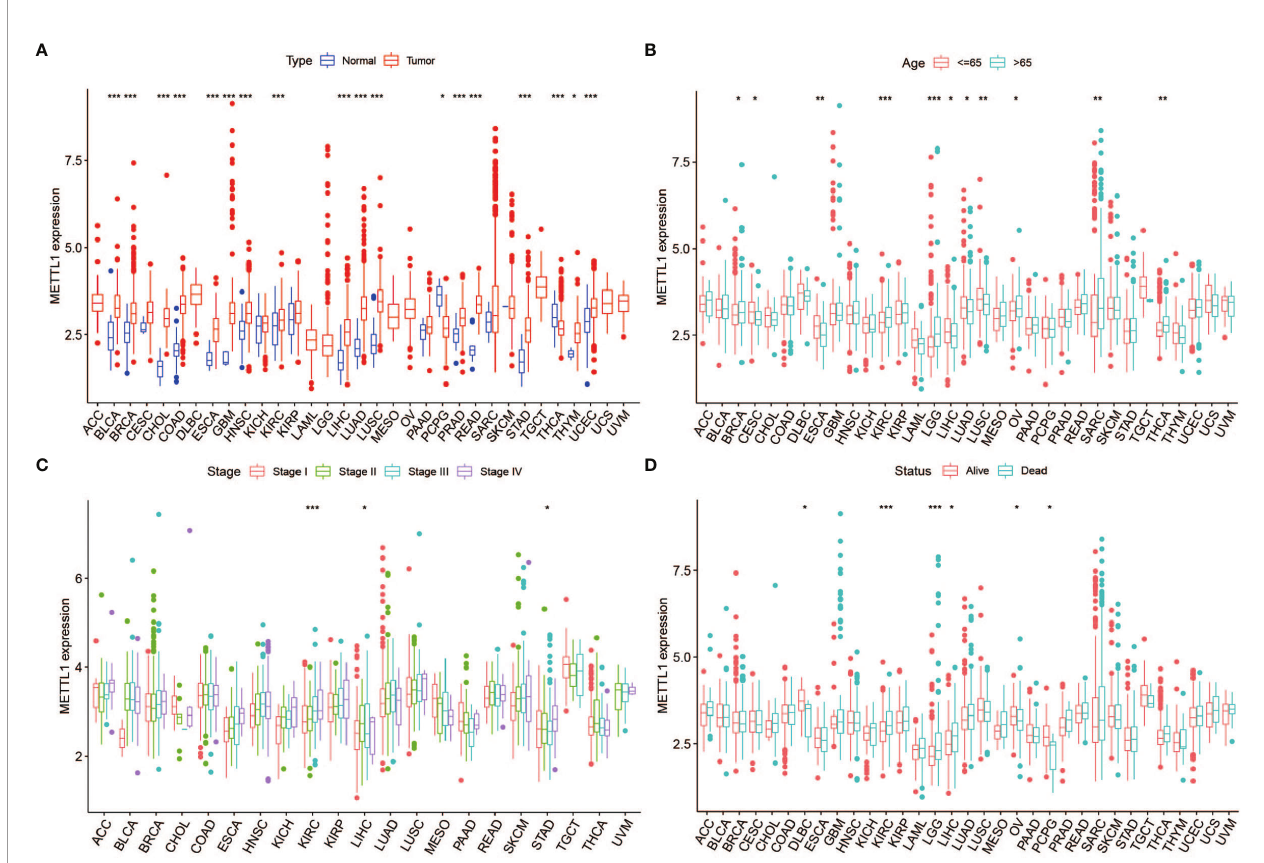
FIGURE 2 | Correlation between METTL1 expression and clinical traits. (A) The expression of METTL1 between normal tissues and tumor among pan-cancer. (B) The relationship between METTL1 expression and age distribution. (C) The relationship between METTL1 expression and tumor stage. (D) The relationship between METTL1 expression and status. * means P < 0.05; ** means P < 0.01; *** means P <